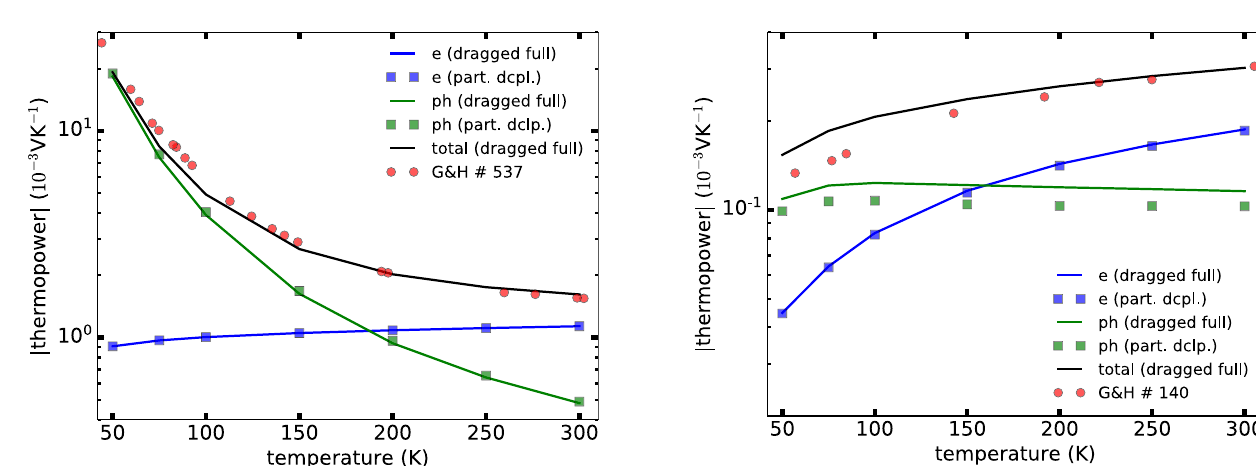
Fig. 2 Temperature dependence of the thermopower of silicon for an n -type carrier concentration of 2.75 × 10 14 cm − 3 . The red circles are measurements (sample 537, concentration 2.8 × 10 14 cm − 3 ) by Geballe and Hull 15 .